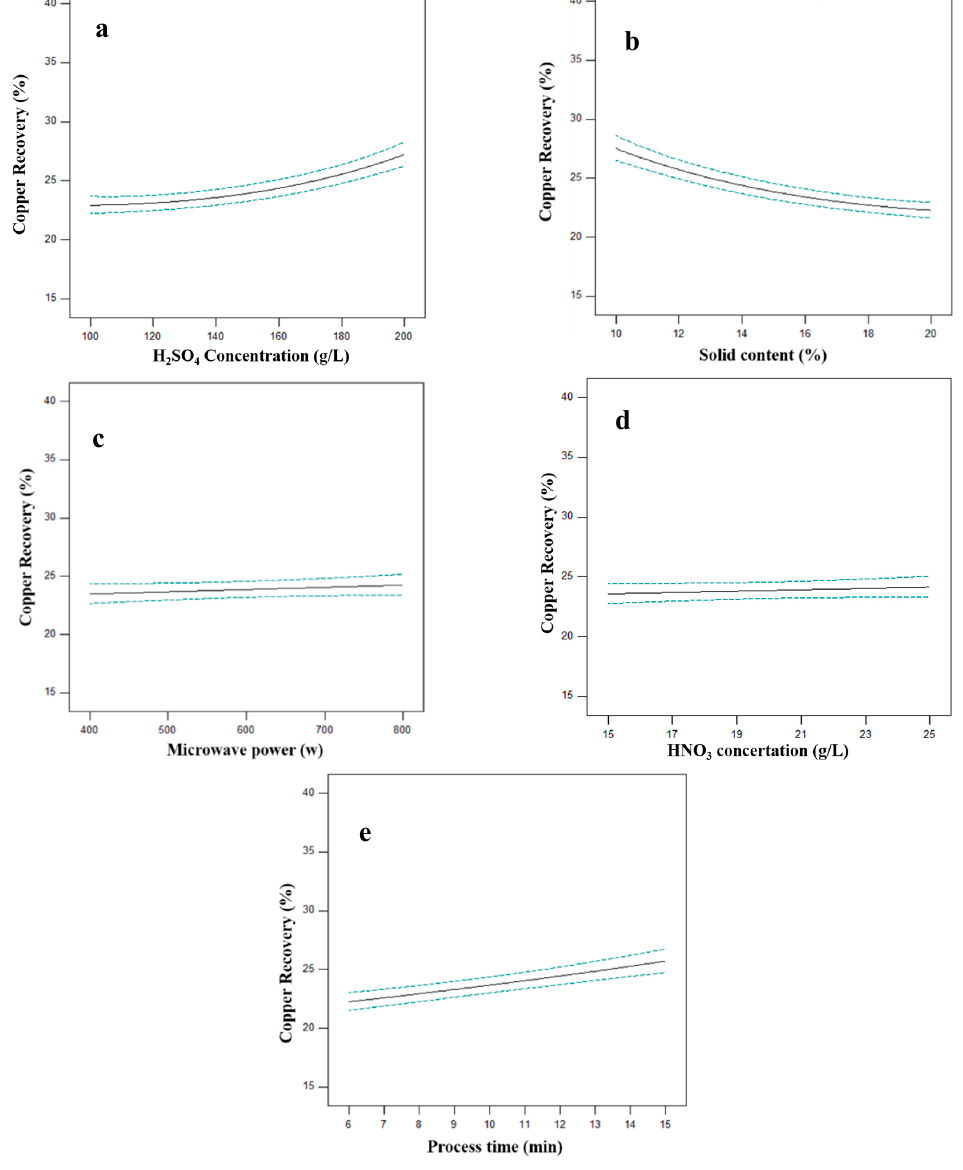
Figure 5. Effect of sulfuric acid concentration ( a ), solid content ( b ), microwave power ( c ), HNO 3 concentration ( d ) and process time ( e ) on Cu recovery (other parameters are held at center level).